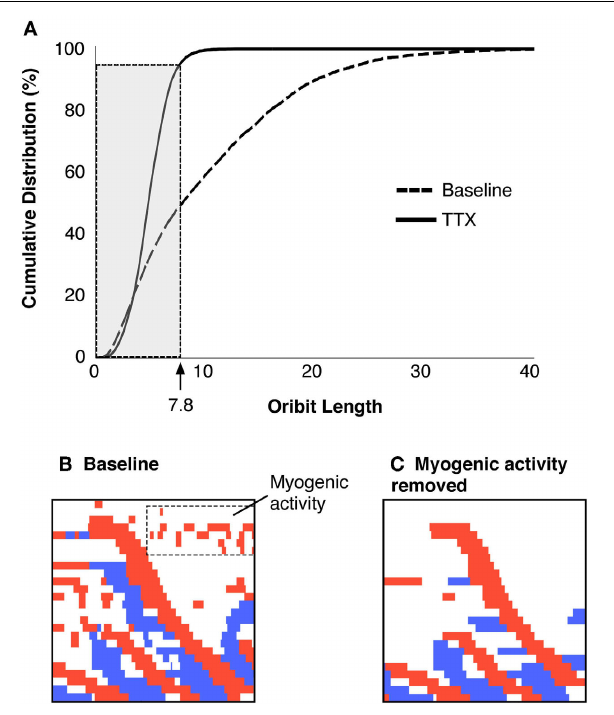
FIGURE 6 | (A) Criteria to identify and remove myogenic activity. The cumulative distribution of orbital lengths calculated from preparations exposed to TTX are plotted (solid black line), with the cumulative distribution without TTX (dashed line, A ). The cutoff that removed 95% of the myogenic activity was identified (value = 7.8). All points on the active-state map with orbit plots of 7.8 or less were removed from the data and remaining activity was considered to be neurogenic. The region shown in Figure 3F is shown with all activity displayed ( B ) and after myogenic activity is removed ( C ).